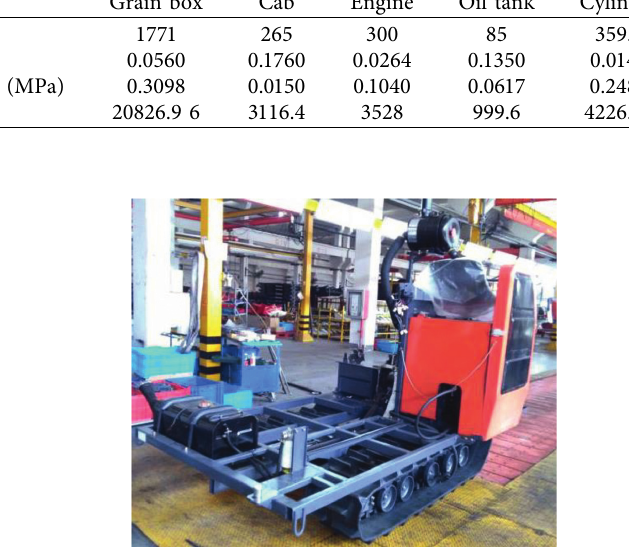
Figure 16: Production of crawler chassis of the combine